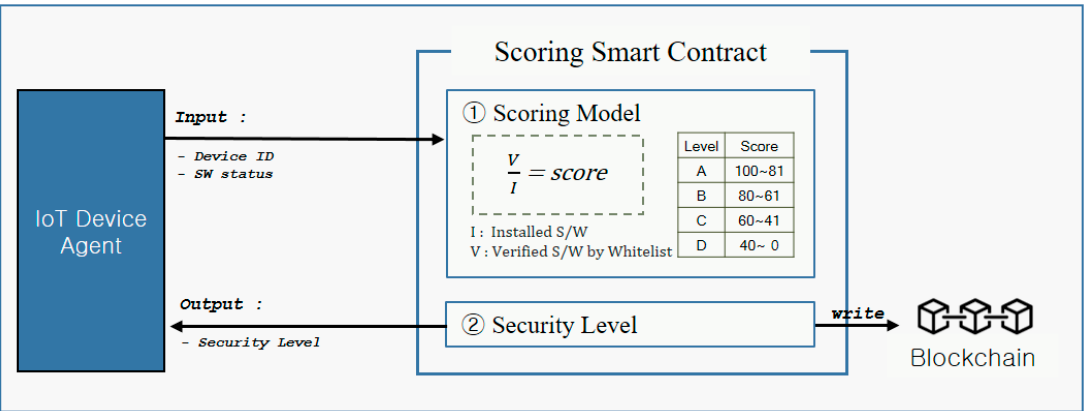
Figure 5. Scoring smart contract.